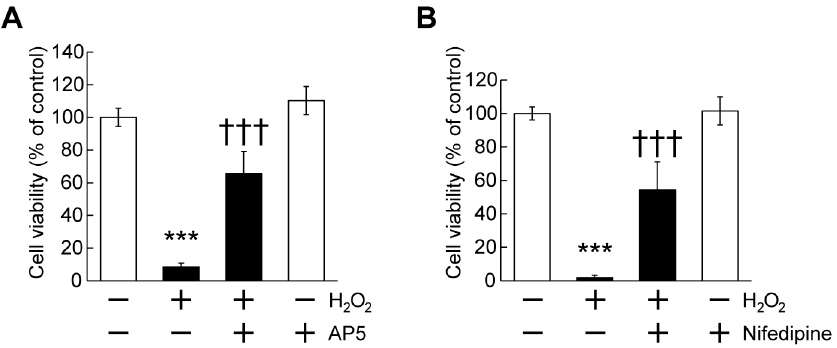
Figure 5. H 2 O 2 exposure caused neuronal cell death via glutamate-mediated excitotoxicity. (A) AP5, an NMDA receptor blocker, suppressed H 2 O 2 -induced cell death. AP5 (10 m M) was added 20 min before H 2 O 2 (50 m M) application, followed by MTT assay. The data represent mean 6 SD (n=6–12). *** P , 0.001 vs. - H 2 O 2 - AP5, {{{ P , 0.001 vs. + H 2 O 2 - AP5 (two-way ANOVA). (B) Nifedipine, a L-type Ca 2 + channel blocker, inhibited cell death. Nifedipine (10 m M) was added 20 min before H 2 O 2 (50 m M) application. The data represent mean 6 SD (n=6–12). *** P , 0.001 vs. -